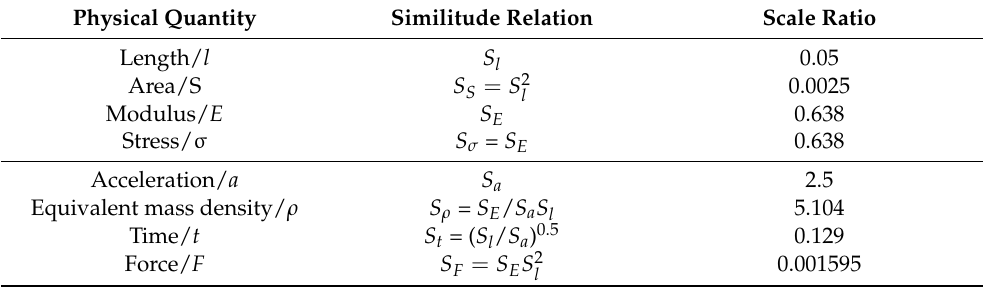
Table 1. Similarity coefficients.